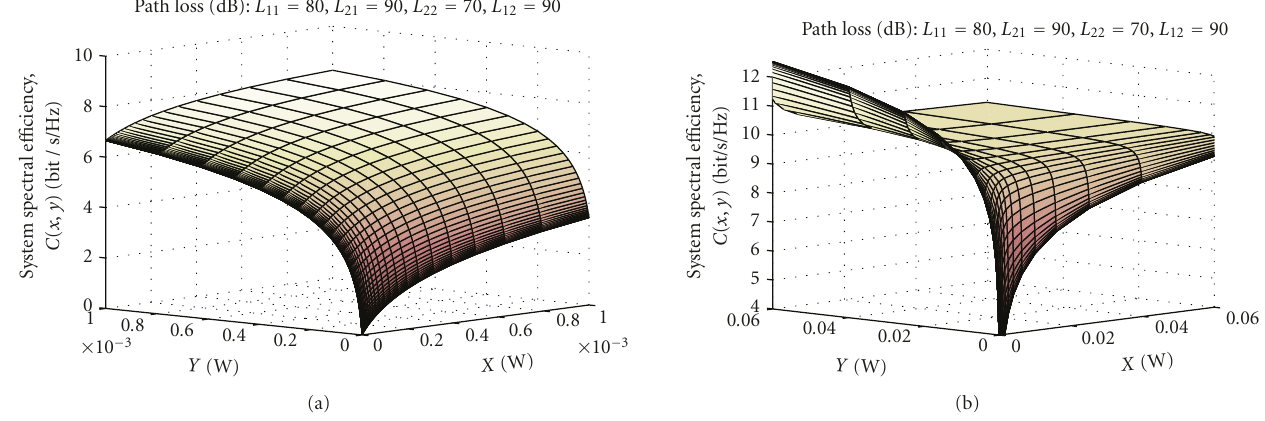
Figure 2: System spectral e ffi ciency C ( x , y ) versus transmit powers x , y = [0, P ]. (a) Max. power P = 1 mW, case where C ( P , P ) > C ( P ,0) and C ( P , P ) > C (0, P ), (b) Max. power P = 60 mW, case where C ( P ,0) < C ( P , P ) < C (0, P ).